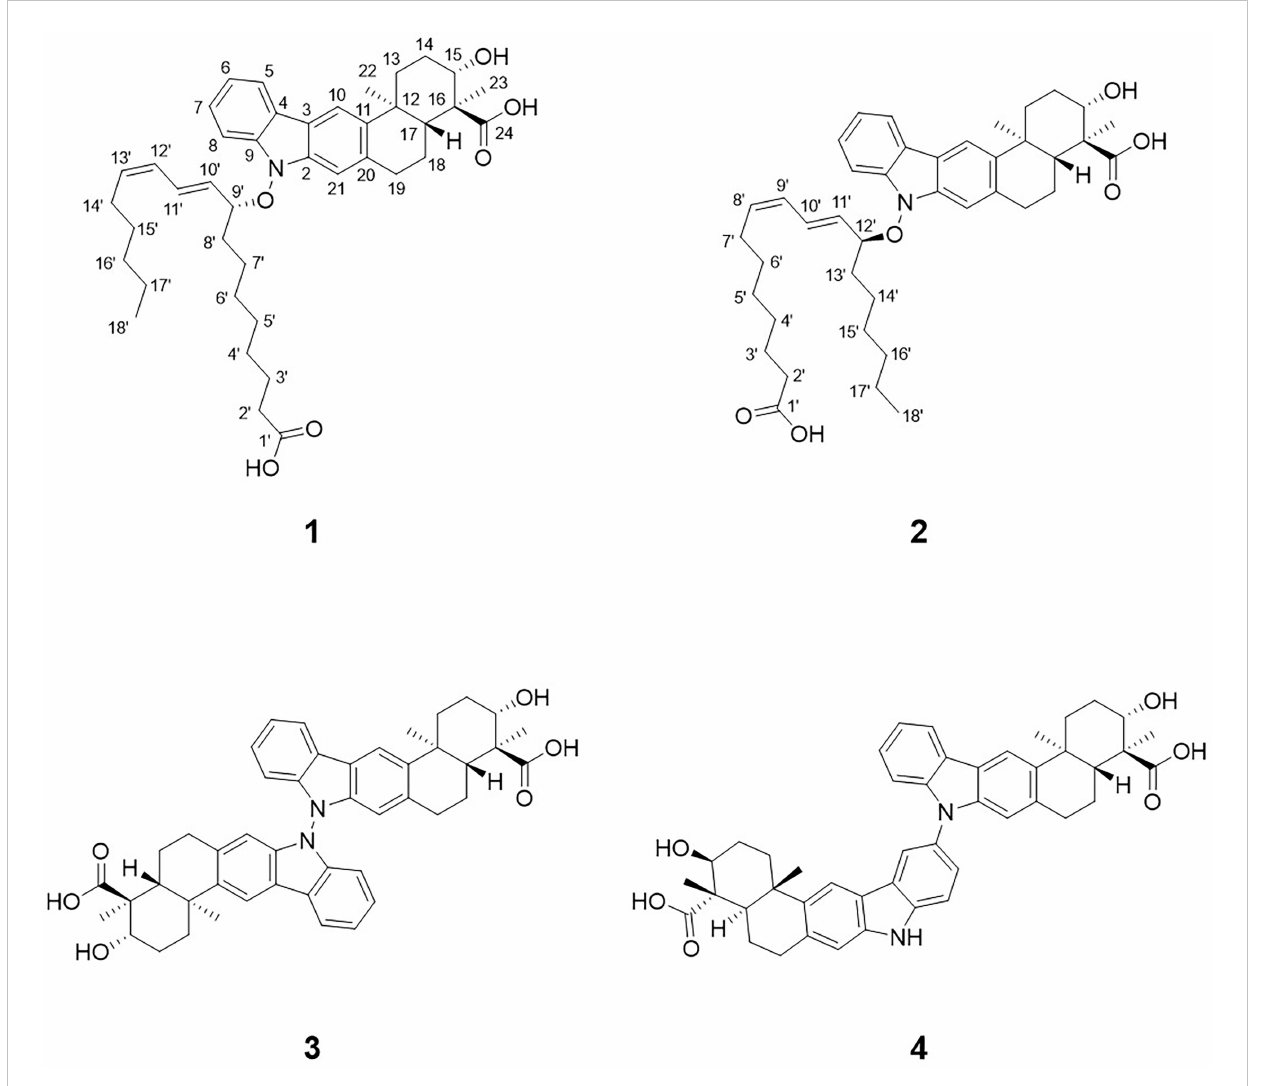
FIGURE 1 Structures of lipoxiamycin A (1), lipoxiamycin B (2), dixiamycin A (3), and dixiamycin C (4).